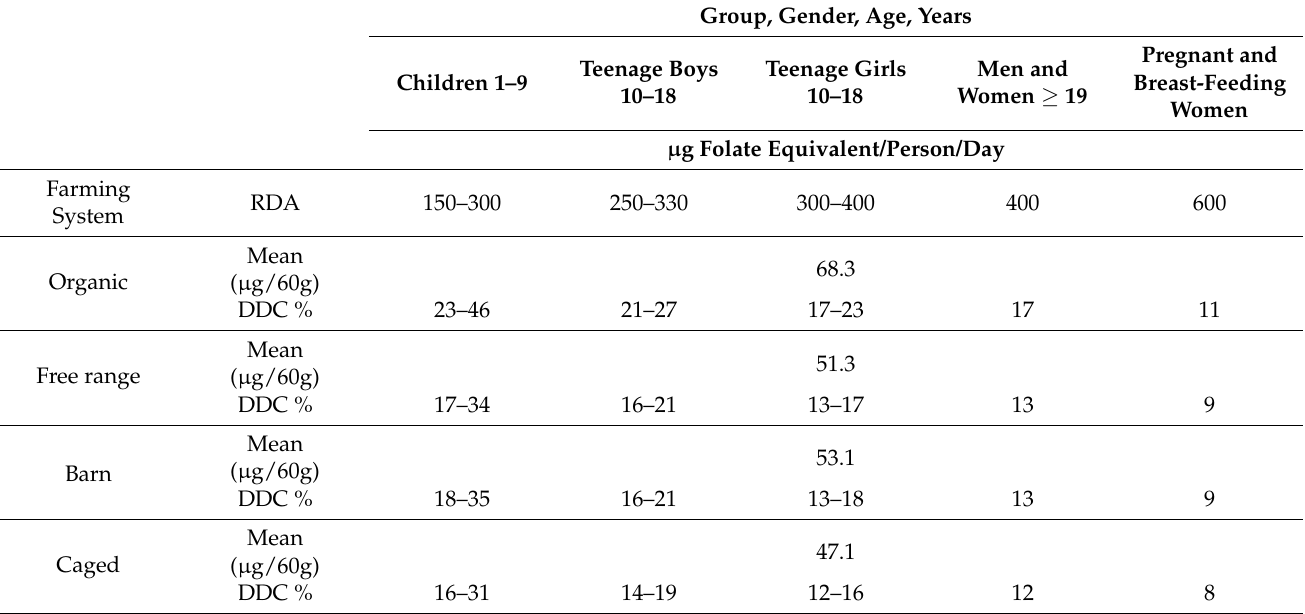
Table 2. Coverage of the daily demand for folates after eating one egg (60 g) from different farming